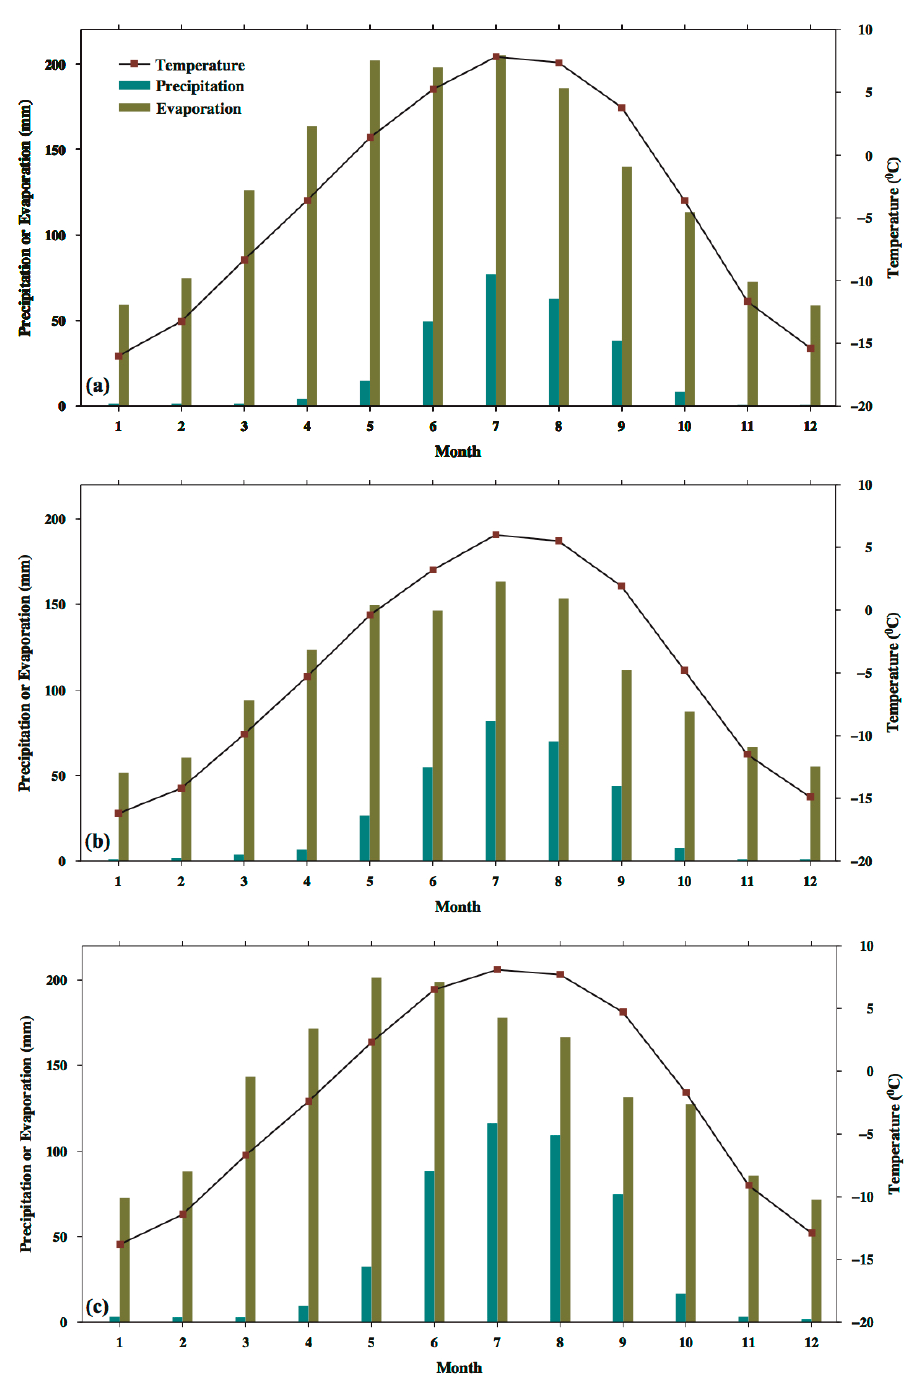
Figure 7. Monthly temperature, precipitation, and evaporation at ( a ) Tuotuohe weather station over 1970–2009; ( b ) Wudaoliang weather station over 1981–2010; and ( c ) Anduo weather station over 1981–2010.